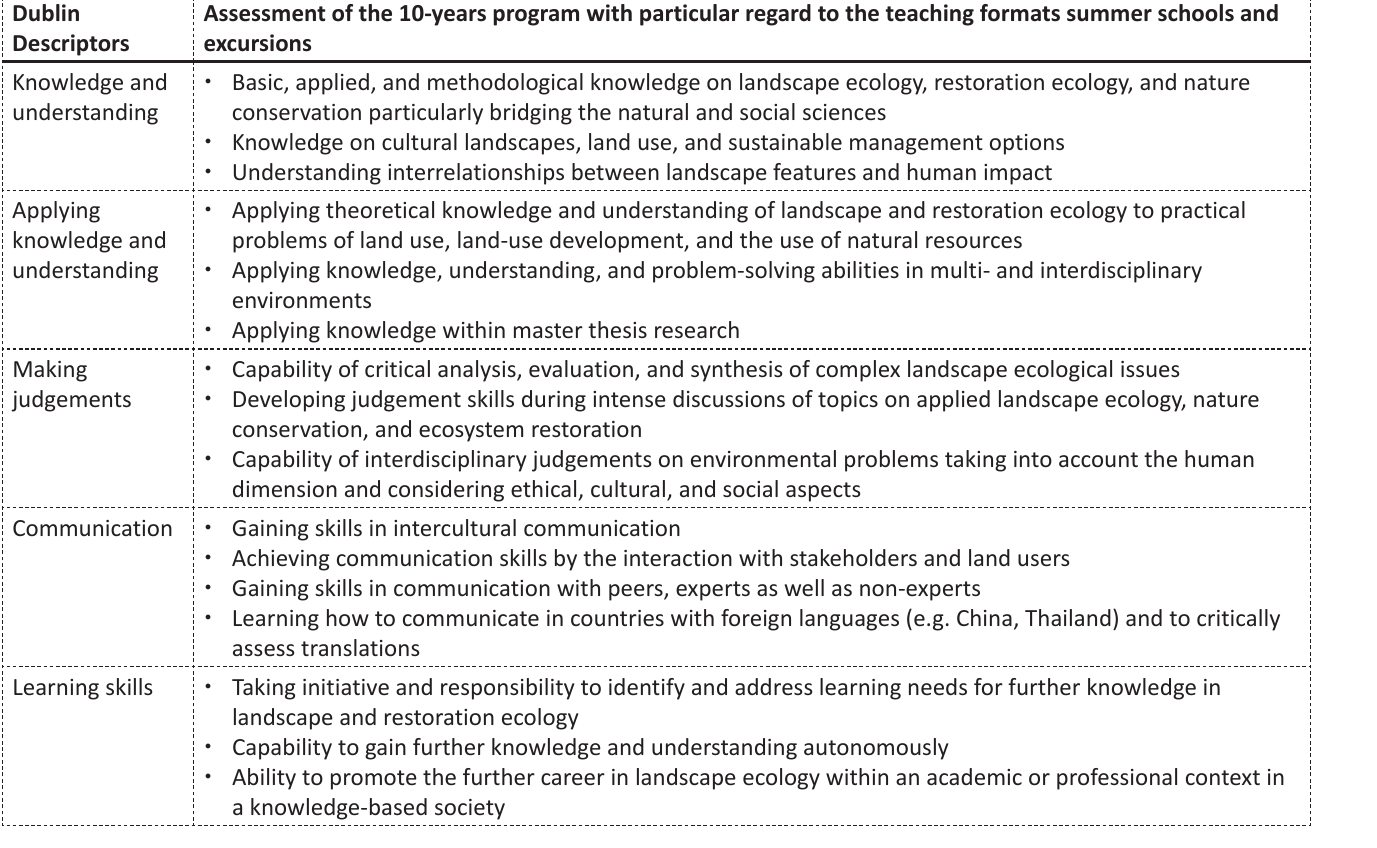
Table 6: Application of the Dublin Descriptors (ECA 2014) to the 10-years study abroad program with its various teaching formats, particularly excursions and summer